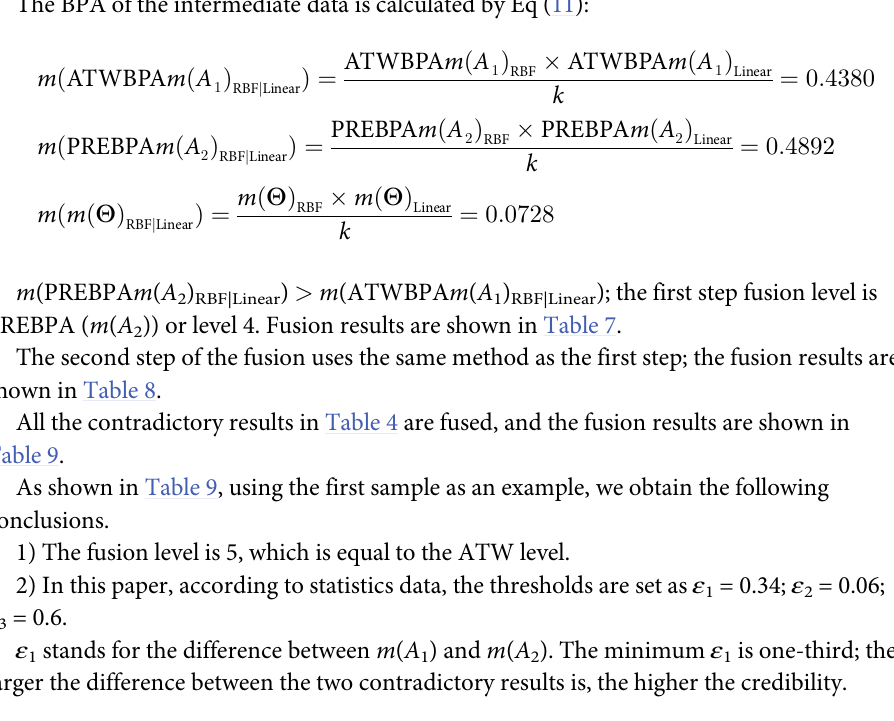
Table 5. The BPAs of the contradictory results.